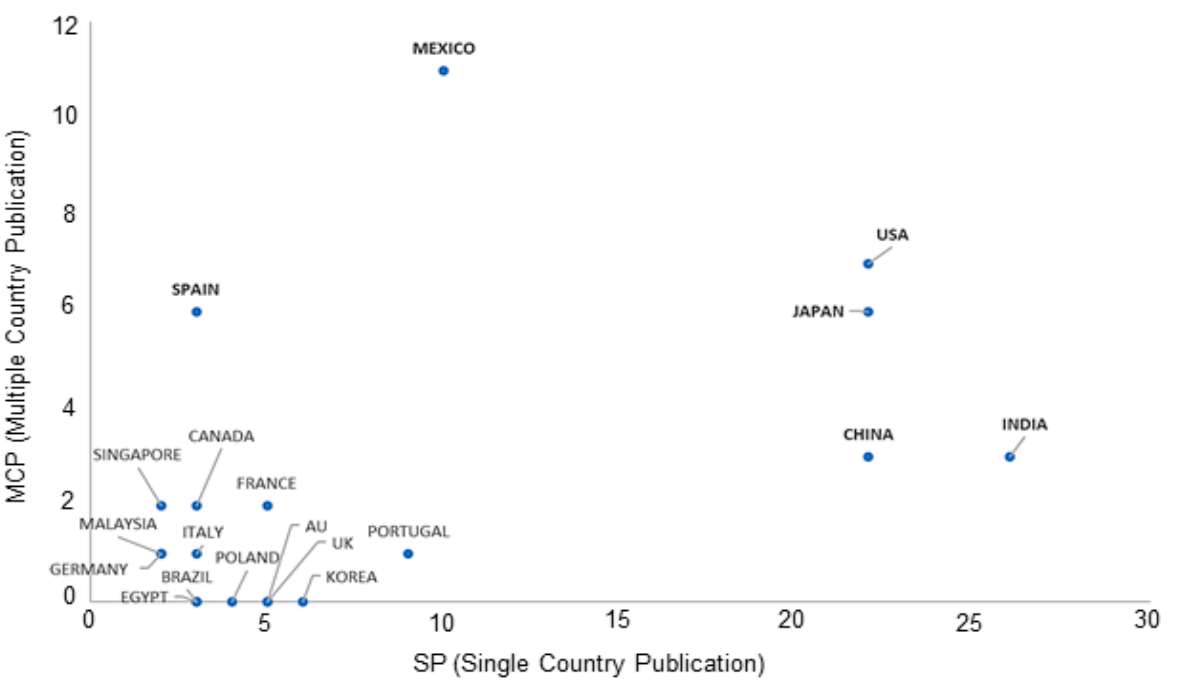
Figure 7. Corresponding author–country collaboration represented by relationship between multiple country and single country publications.